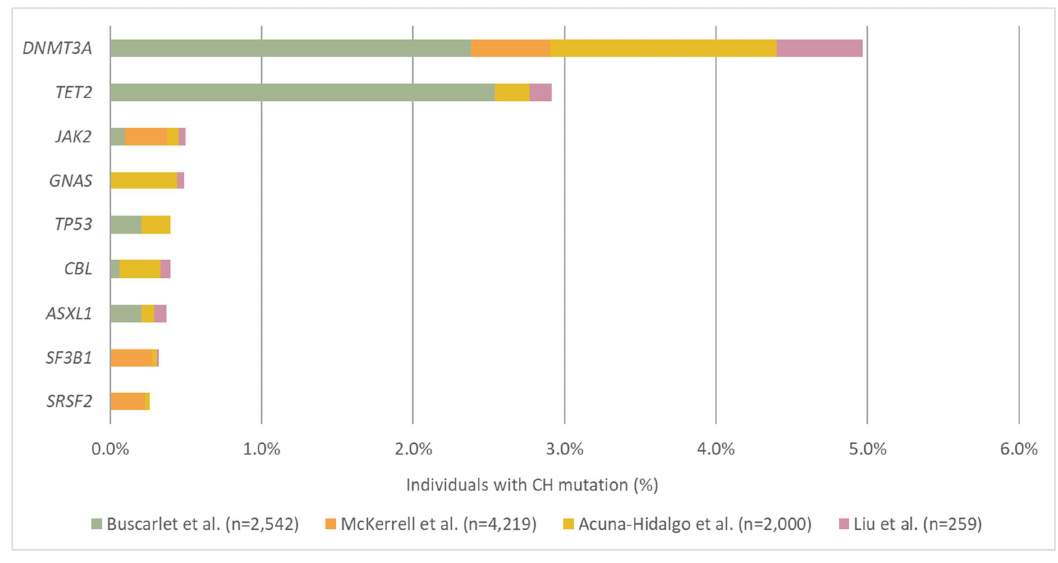
Figure 2. Most frequently altered CH genes detected in healthy individuals. The nine most frequently altered CH genes were selected based on the 4 published studies using targeted sequencing of white blood cells from healthy individuals. The prevalence of each altered gene was calculated by adding the total number of individuals detected with a CH mutation from the gene and divided by the total number of study objects across 4 studies. Studies that did not cover the genes in its panel were excluded from the calculation of the total number of study subjects to avoid bias. The prevalence of the selected CH genes was calculated in the same way for studies that used WGS/WES. ( a ) Prevalence calculated from the WGS/WES studies. ( b ) Prevalence calculated from the targeted sequencing studies.